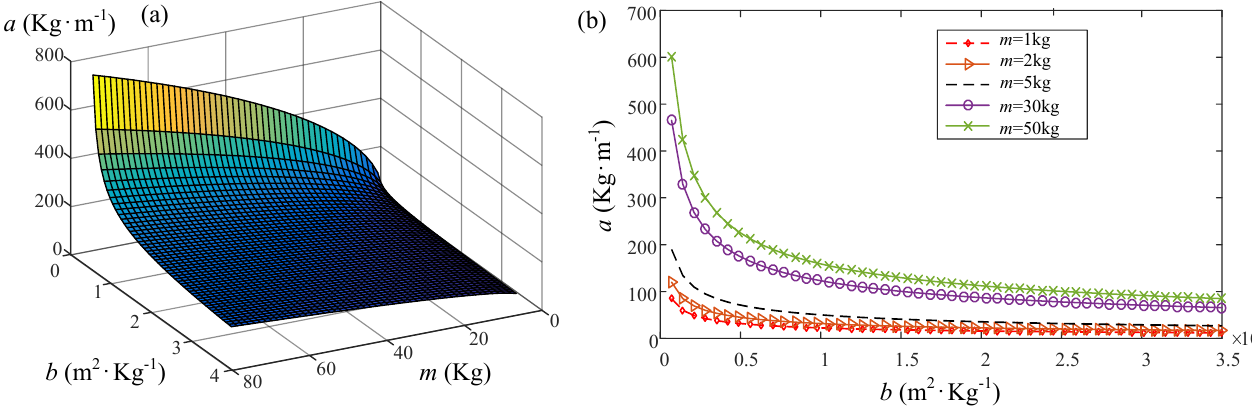
Figure 5. Parameter ranges under linearization condition ( m* ≤ 1%): ( a ) characteristic parameter relationship; ( b ) certain mass of the unit equipment m.